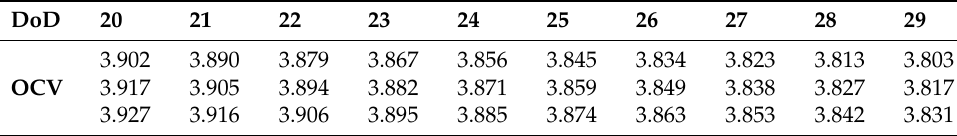
Table A3. OCV models parameters for DoD from 20% to